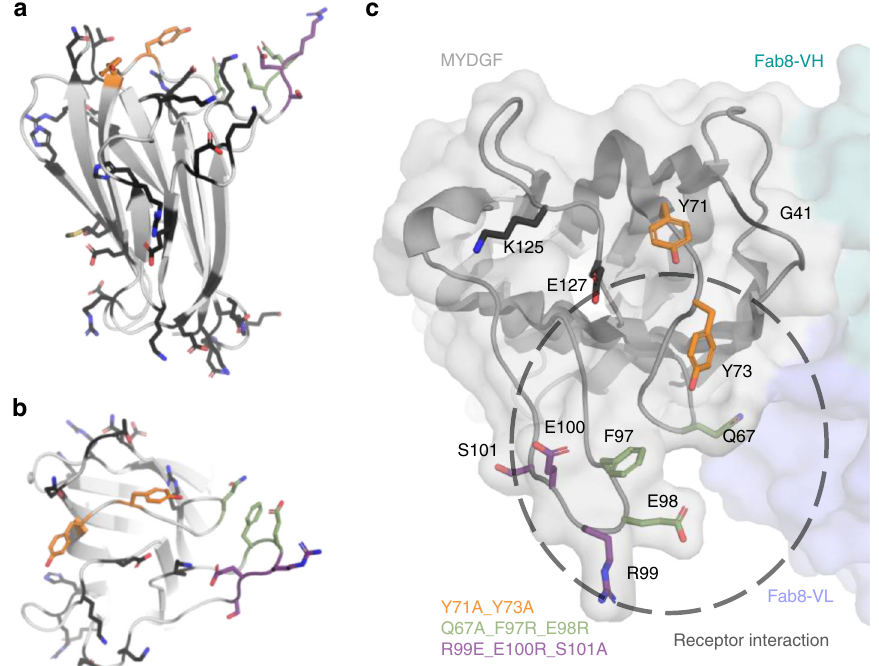
Fig. 5 MYDGF patch mutations and MYDGF receptor epitope. a Distribution of all (black) and the functionally important mutated residues (green, purple and orange) on the MYDGF surface in side view. b Distribution of all (black) and the functionally important mutated residues (green, purple and orange) on the MYDGF surface in top view. c Variants Q67A_F97R_E98R (green), R99E_E100R_S101A (purple) and Y71A_Y73 (orange) are located on the top face of MYDGF on loops 5 and 7. Fab8 (blue and turquois) is recognizing the β -sandwich edge of MYDGF including the N-terminal residues 1 – 18. A circle with dashed line marks the area on MYDGF, which facilitates interaction to the unknown MYDGF